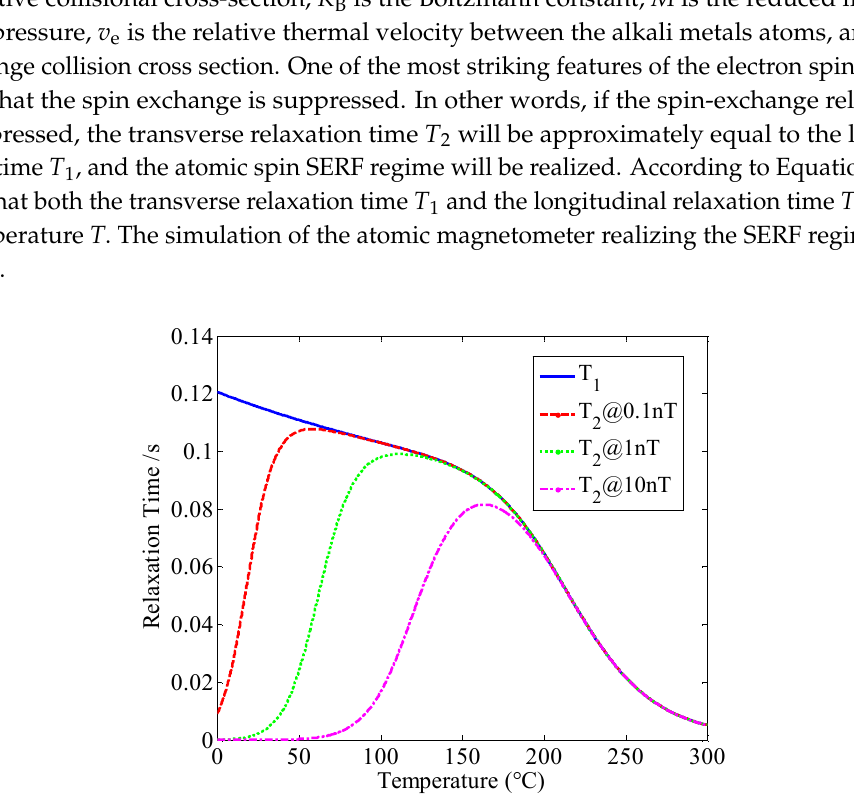
Figure 5. Simulation of the SERF atomic spin magnetometer realizing the SERF regime.